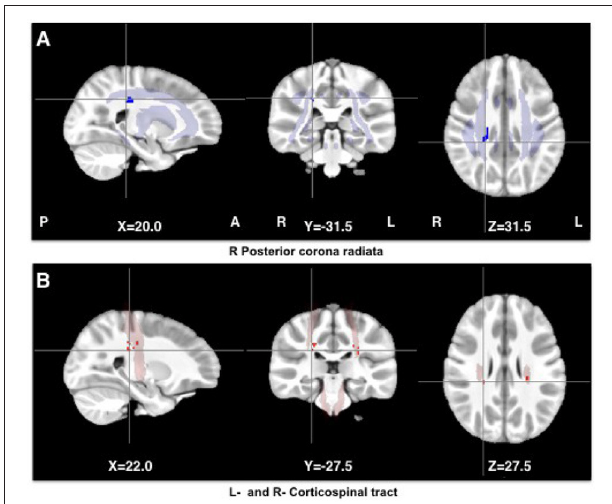
FIGURE 2 | Clusters showing higher FA (blue) and lower MD (red) in HIV exposed uninfected (HEU) children compared to unexposed uninfected (HU) children. The clusters were overlayed on masks of the corresponding tracts (JHU White-Matter Tractography